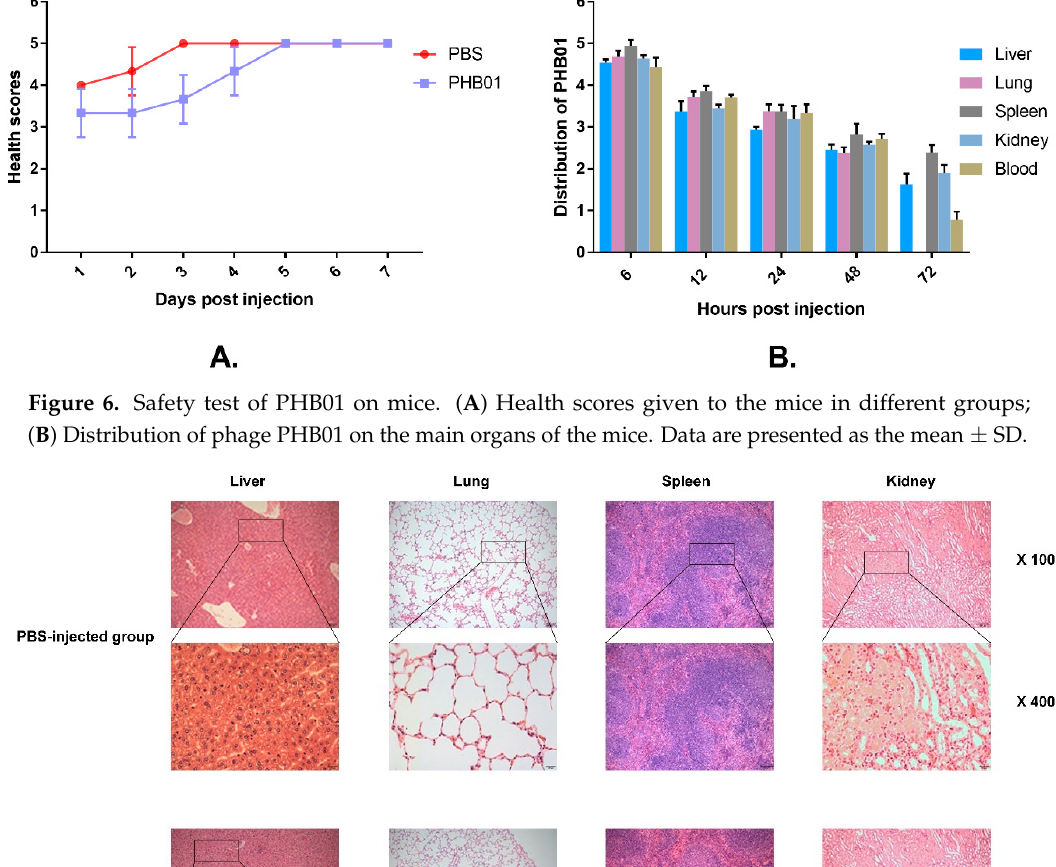
Figure 5. A co-linearity comparison diagram of the genomic organization at the nucleotide level between Pasteurella phages PHB01 and PHB02. The figure was generated via Easyfig v.2.0. The color code refers to the BLASTn identity of those regions between genomes. Arrows represent putative CDSs encoded by different genomes.